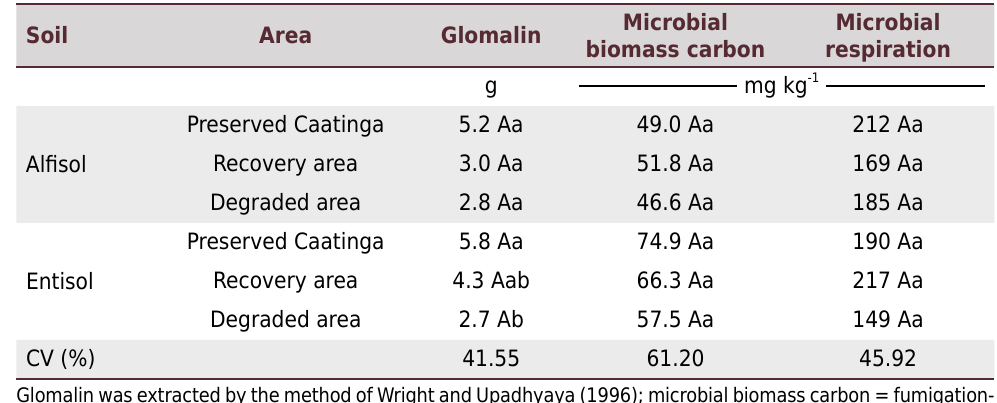
Table 4. Biological properties of an Alfisol and an Entisol of the Seridó Desertification Region, Parelhas, Rio Grande do Norte, from the preserved Caatinga (strata: catingueira, jurema, marmeleiro, and between trees), the recovery area with jurema (strata: jurema and between trees), and the degraded area without plant cover, at layer of 0.00-0.10 m, in the dry